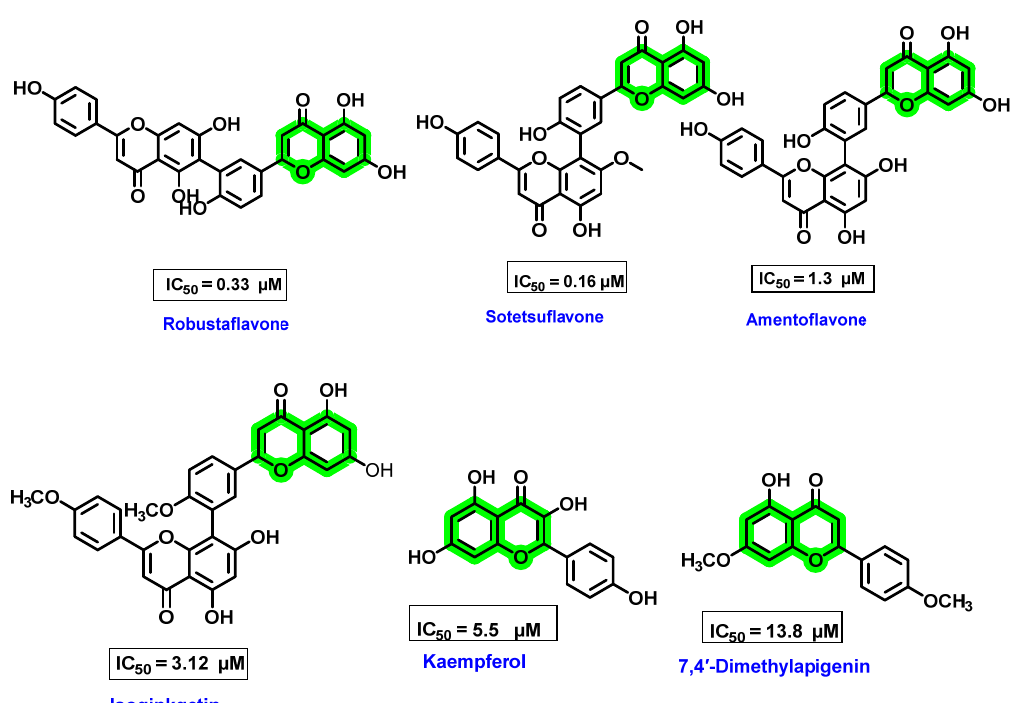
Figure 11. Structure of biflavonoids isolated from Dacrydium sp. and flavonoid monomers showing inhibitory activity against DENV NS5 RdRp and their IC 50 values.